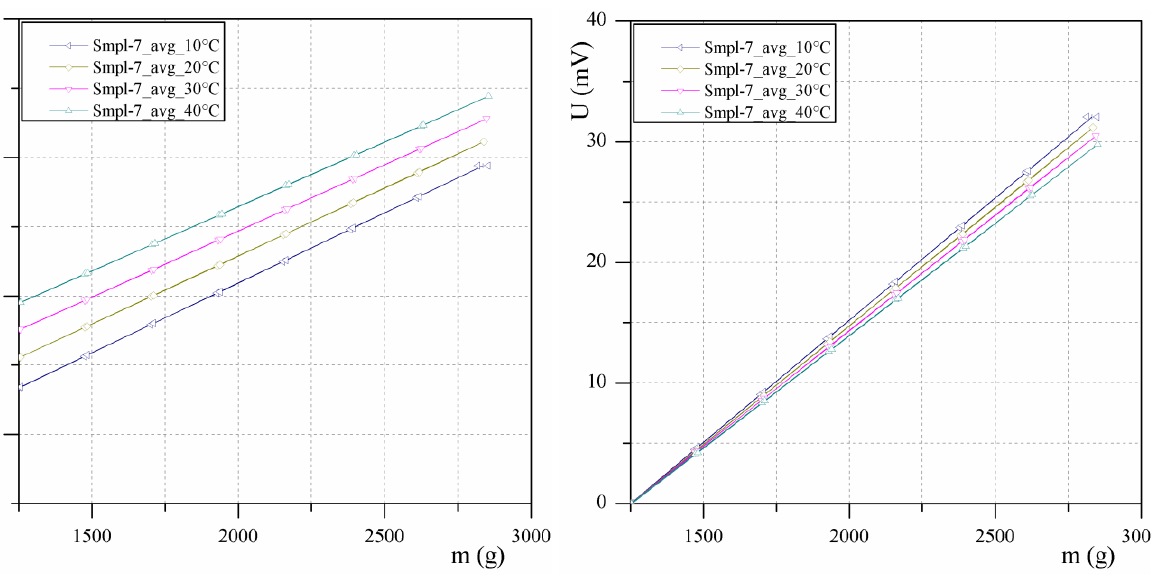
Figure 11. (a) Output voltage versus mechanical load of the sensor at different temperatures and (b) the same results using the tare function.